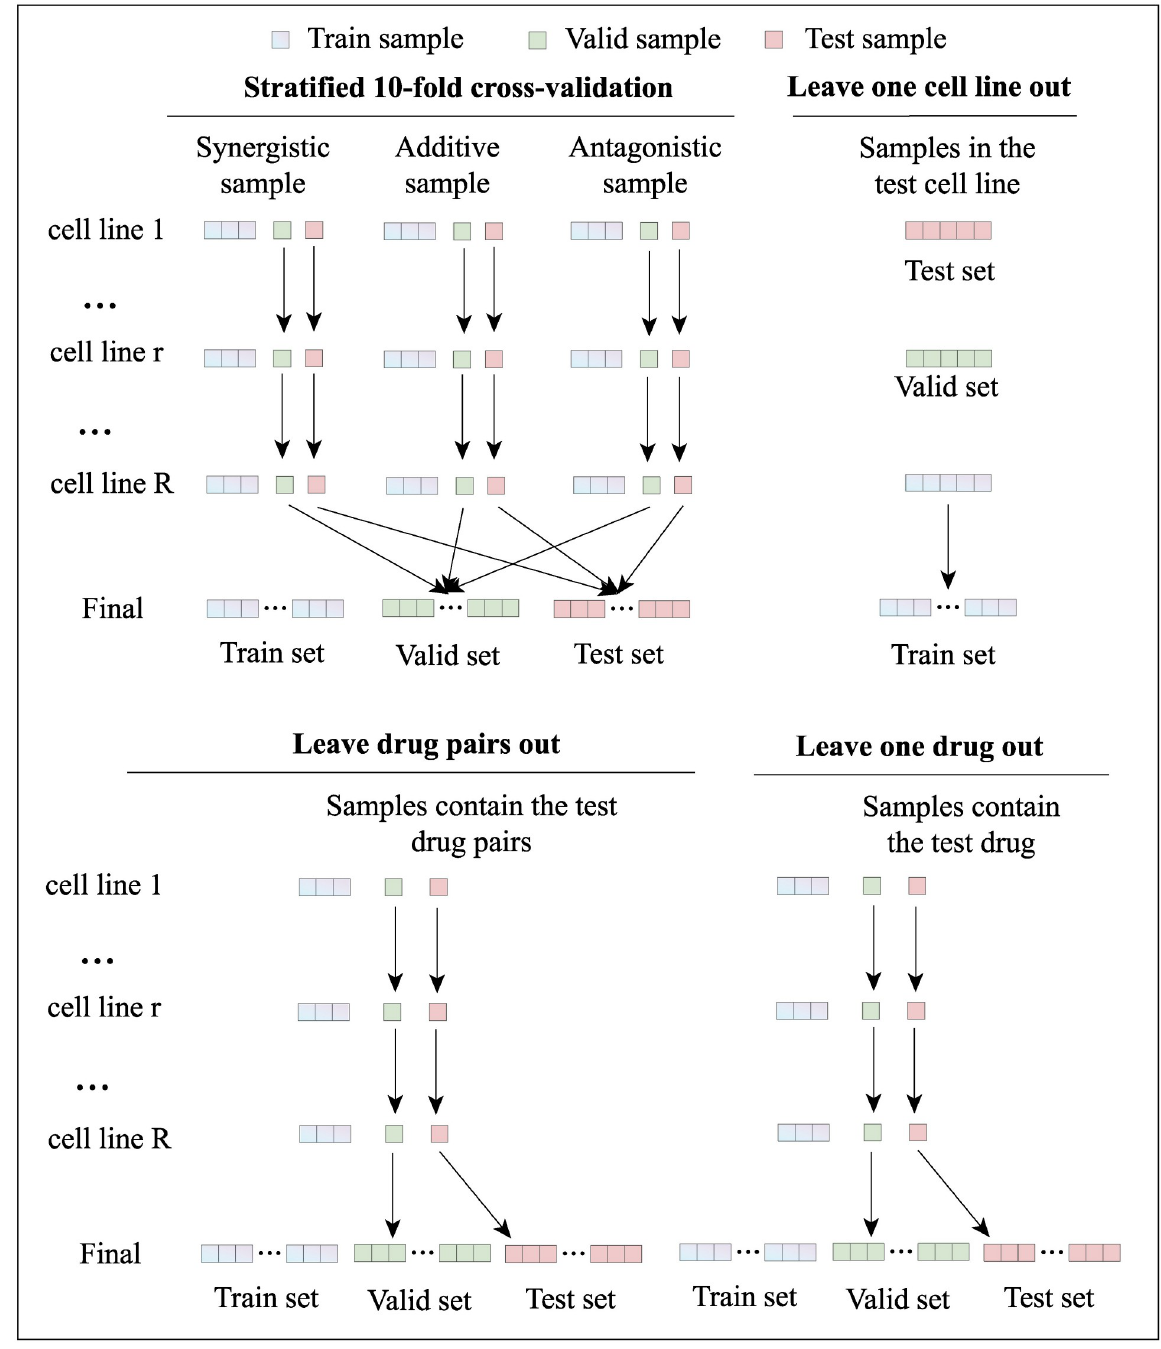
Fig 4. The schematics of different cross-validation strategies.